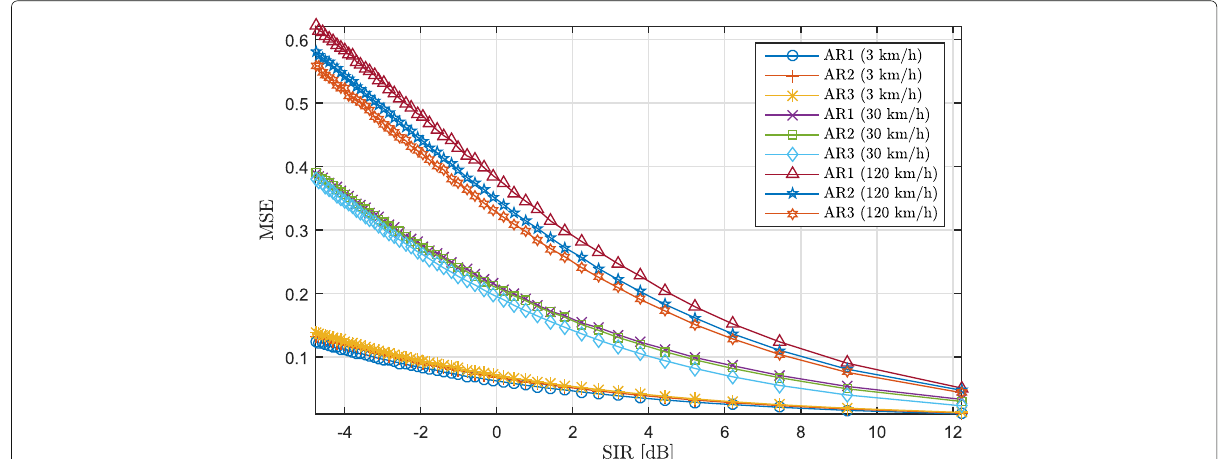
Fig. 10 Comparison between AR models with different orders with respect to mean squared error as a function of the signal-to-interference